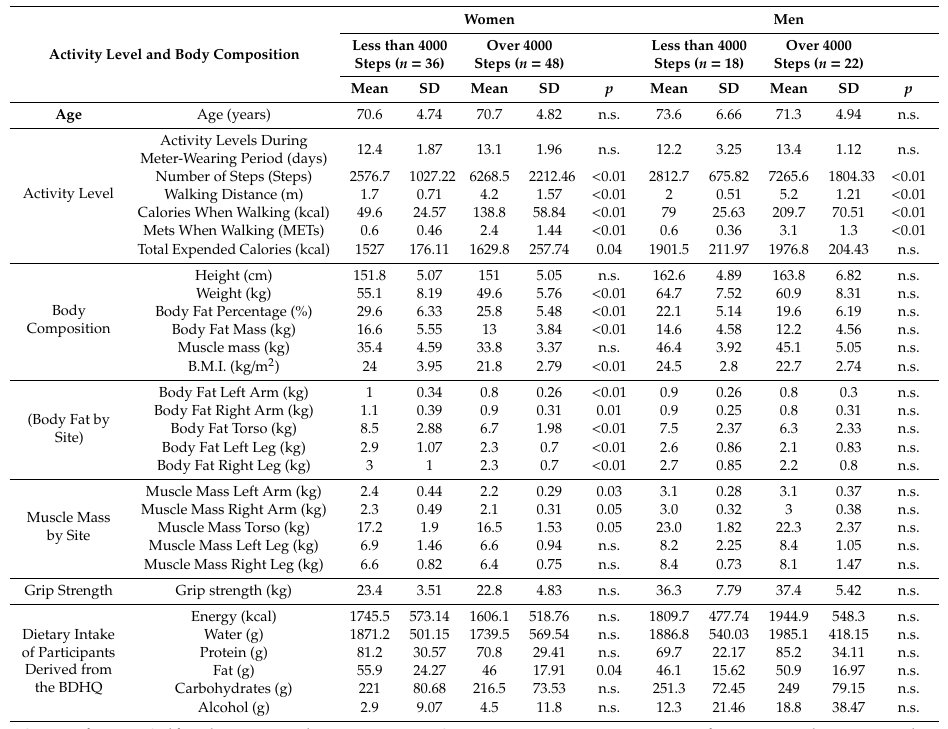
Table 2. Comparison by number of